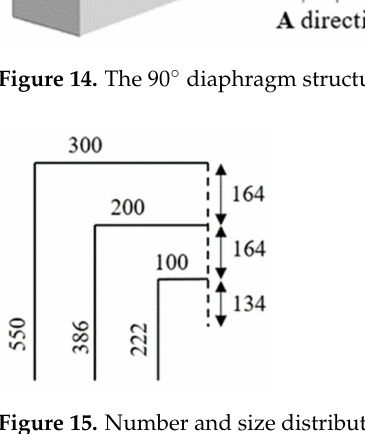
Figure 15. Number and size distribution of 90 ◦ diaphragm